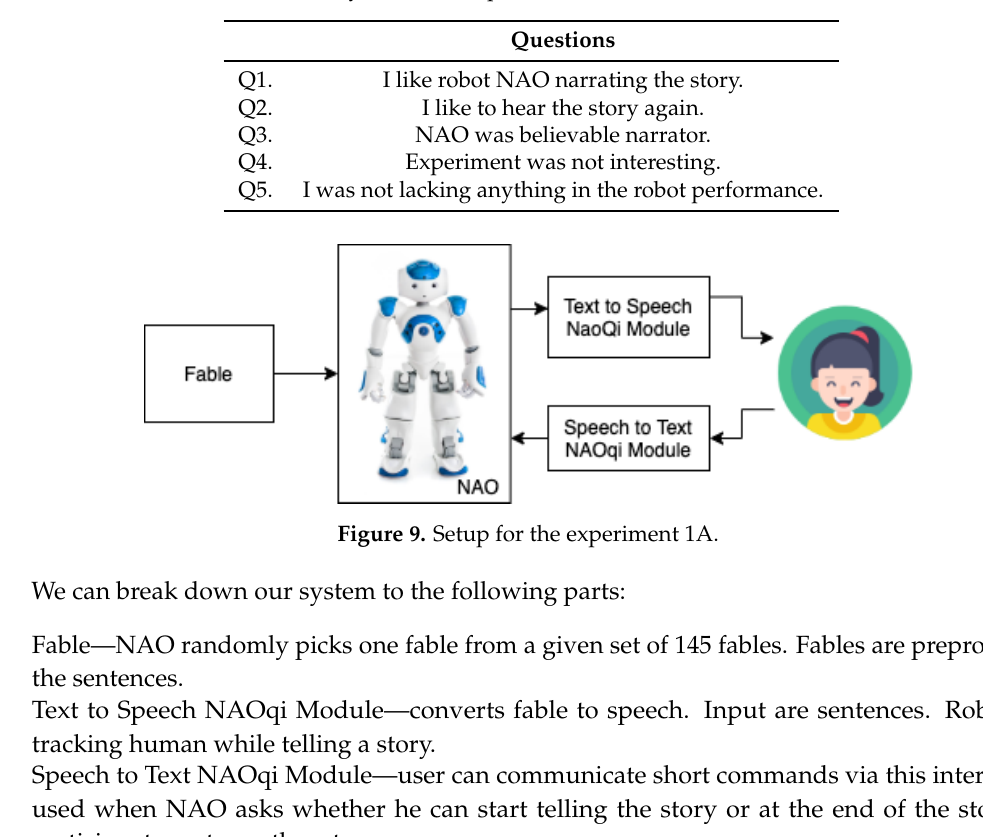
Table 15. Survey about robot performance in the first two scenarios.